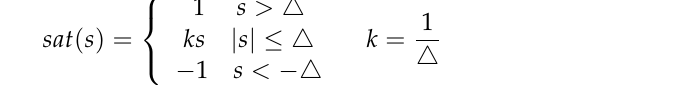
Figure 11. Fuzzy control output.